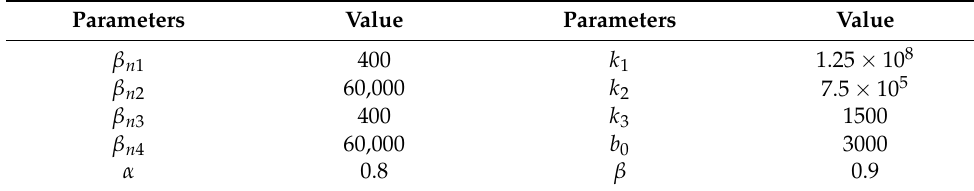
Table 2. Parameters of the proposed method.